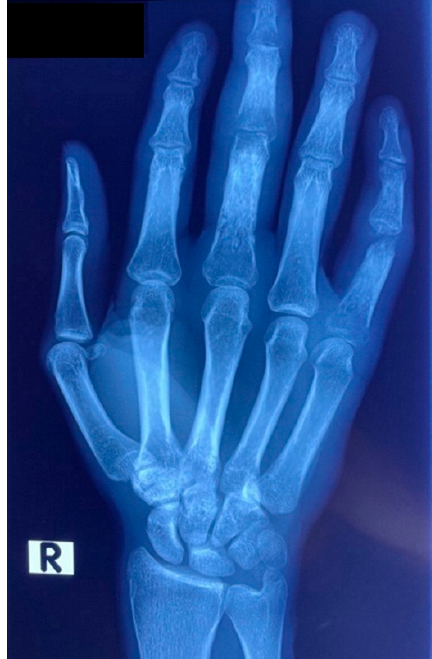
Figure 8. X-ray of patient’s right hand, demonstrating a periosteal reaction in the 3 rd proximal phalanx and osteolysis of the 5 th proximal interphalangeal joint.